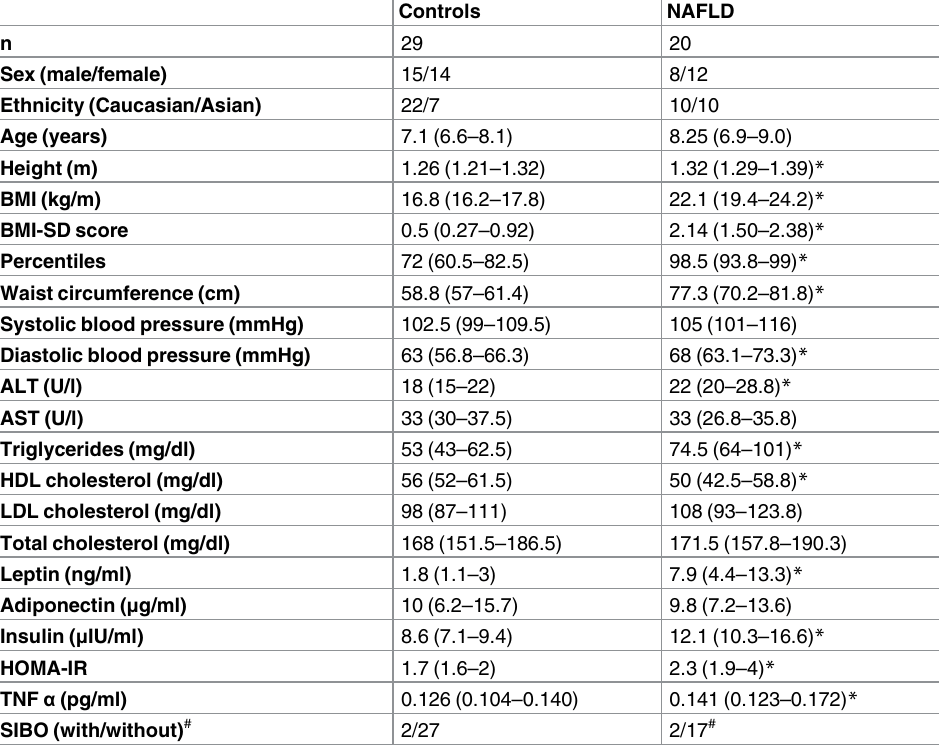
Table 1. Characteristics of controls and children with early signs of NAFLD.